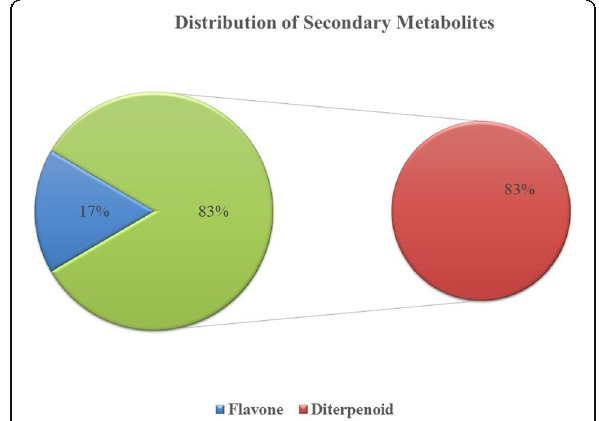
Fig. 5 Distribution of antimalarial active diterpenes and